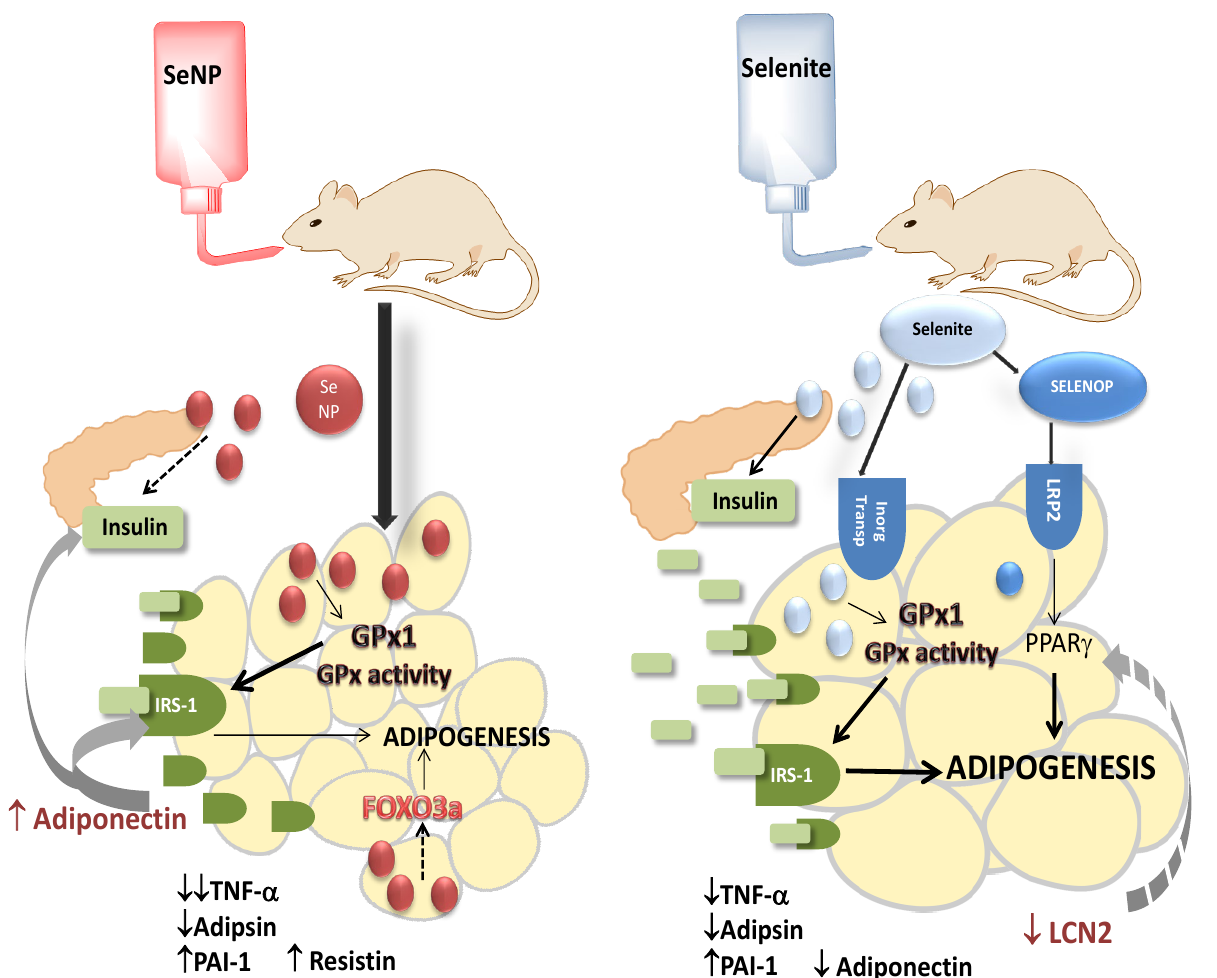
Figure 7. Possible mechanisms implicated in the antagonistic effects of low selenite and SeNP supplementation on WAT homeostasis during adolescence. Selenite supplementation favors adipocyte maturation and fat deposition in WAT by increasing insulin secretion and IRS-1 expression, enhancing the insulin signaling pathway and adipogenesis. It also reduces LCN2, a PPAR γ inhibitor, and abrogates adipogenesis arrest. As a hypothesis, selenite could be previously transformed into SELENOP, which when arrives to LRP2 and activates PPAR γ . By contrast, SeNP supplementation impairs insulin secretion, which cannot properly activate the insulin signaling pathway and adipogenesis, despite high amounts of IRS-1 being expressed and adiponectin being secreted. SeNPs also decreased FOXO3a expression, related to lipid accumulation and inflammation in adipocytes, by promoting autophagy.